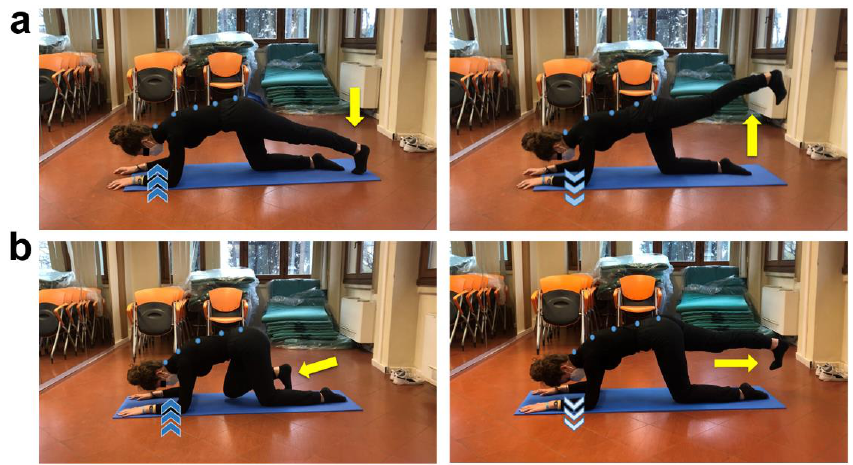
Figure 6. Lower limb extension and flexion in quadruped position. ( a ) Quadruped position, neutral spine attitude (light blue dots), place both elbows shoulder-width apart on the floor, keep the ground knee right under the homolateral hip and straighten backward the contralateral lower limb with dorsiflexed foot (pointing down yellow arrow). Inhale (dark blue arrows), then exhale (light blue arrows) while extending the straight lower limb on sagittal plane (pointing up yellow arrow). Three sets of 45 s for each lower limb, 15 s of recovery. ( b ) Repeat the previously described exercise performing a flexion of the other lower limb on sagittal plane by bringing the knee closer to chest with dorsiflexed homolateral foot (short yellow arrow), and then extend the same lower limb backward (diagonal yellow arrow). Three sets of 45 s for each lower limb, 15 s of recovery.